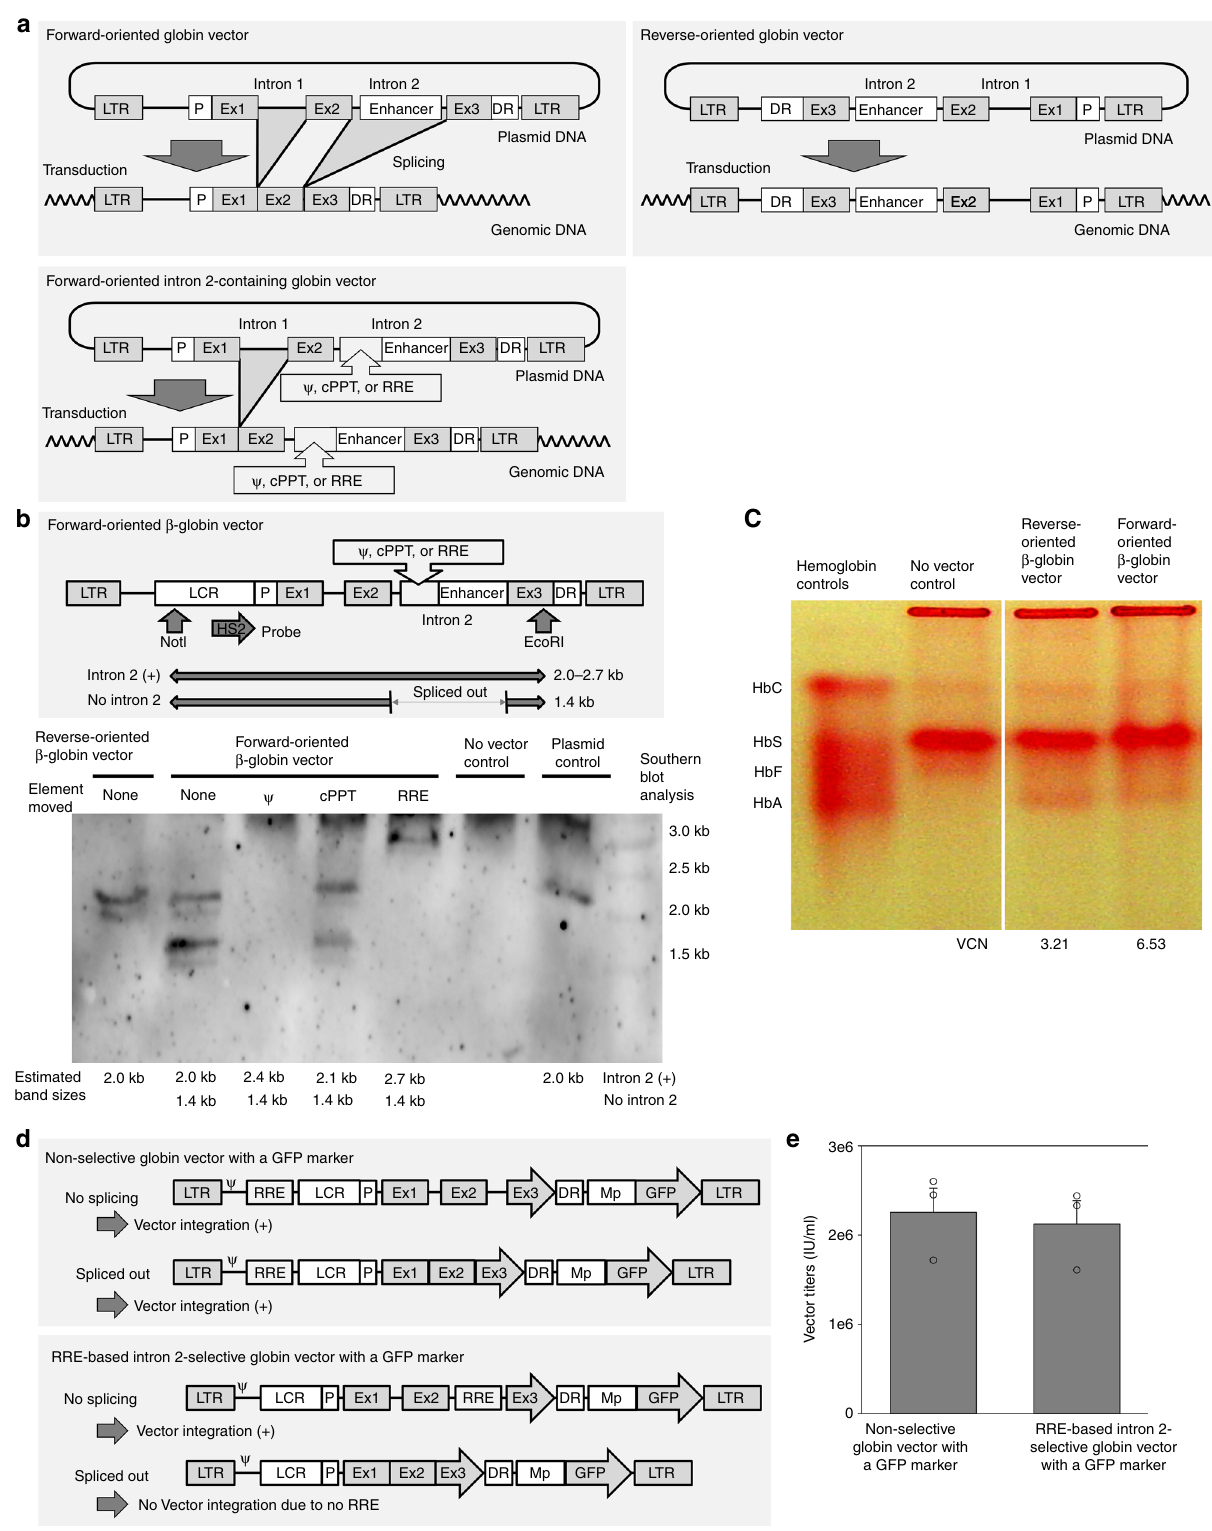
lentiviral vectors created by insertion of the packaging signal into intron 2 did not integrate, suggesting the packaging signal is disrupted by changing its position in the vector construct. We con fi rmed β -globin expression from the forward-oriented RRE-based vector by adult hemoglobin production at the protein level among human erythroid cells derived from